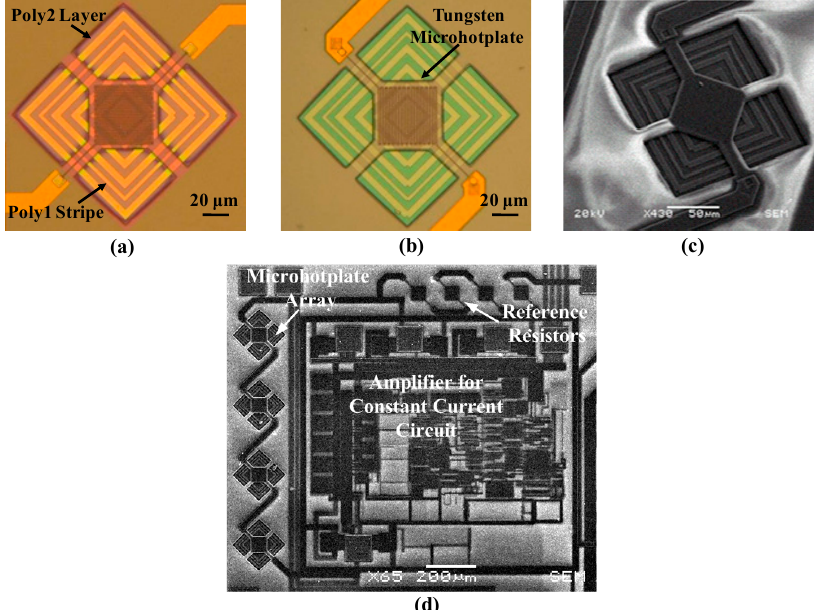
Figure 3. Pictures of the multifunctional sensor platform. ( a ) Optical microscopy picture of the tungsten microhotplate before etching; ( b ) Optical microscopy picture of the tungsten microhotplate after etching; ( c ) scanning electron microscope (SEM) picture of the tungsten microhotplate; ( d ) SEM picture of the platform for sensors.